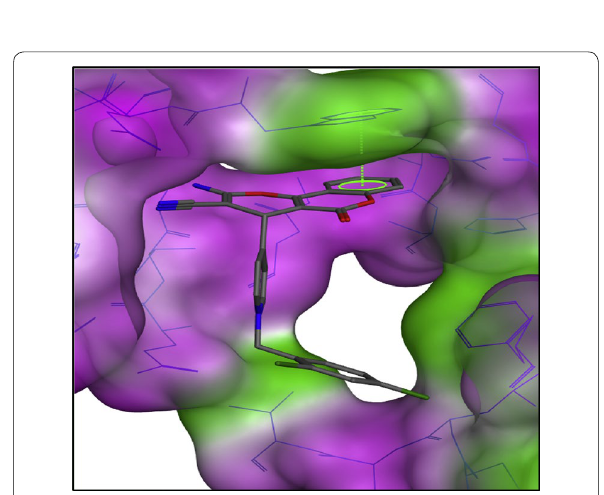
Fig. 25 The predicted binding mode of compound C17 in the active site of BuChE